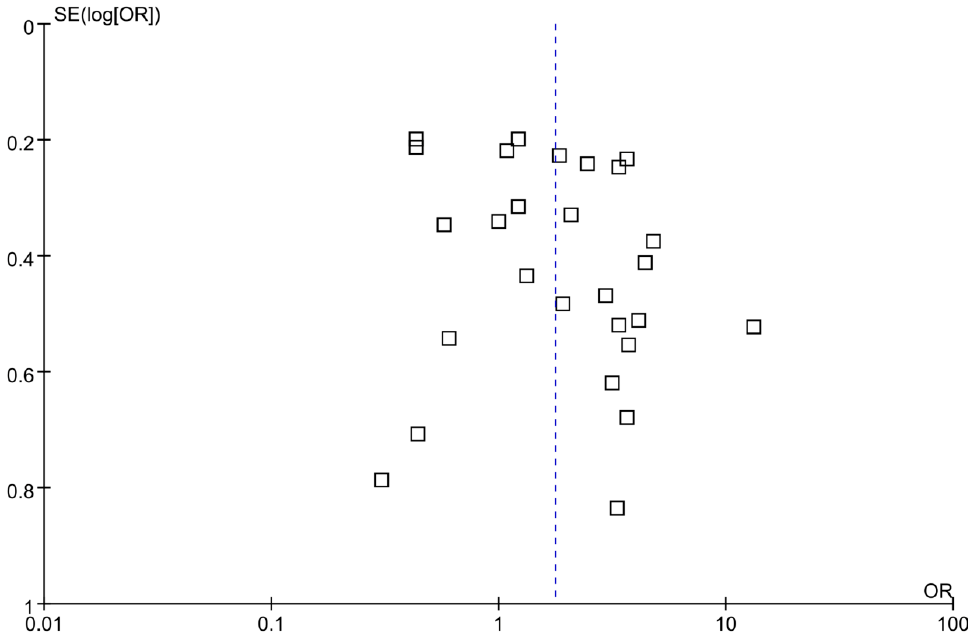
Figure 7. A funnel plot for publication bias.